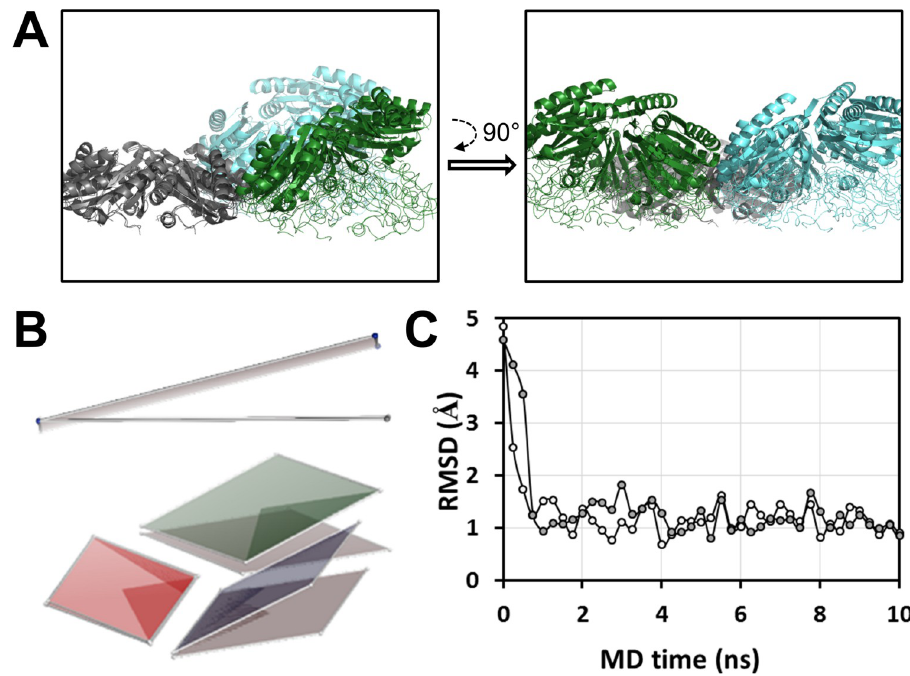
Fig 2. MD simulations on the PduA Sent tri-hexamer. A , Comparison of the average structure of a 20 ns MD simulation on PduA Sent (cartoon) with the situation at time 0, corresponding to the 3NGK crystal structure (thin traces). The two structures were superposed on backbone atoms of the most to the left hexamer (left view). An orthogonal view is shown in the right. B , The same comparison is illustrated by two means: On top, with planes that were elaborated from the coordinates of the center of mass (COM) of each hexamer. Grey spheres are from the starting structure, in blue for the MDs average structure. The view is approximately seen as in the left representation of panel A. Consequently, the traverse view of the plane in the crystal structure results in a flat trace. Bending during the MDs induces the trace to displace upwards or downwards. In the bottom representation, hexamers of the starting structure or MD average are represented by gray or colored planes, respectively. Each plane was prepared from the C α positions of Ala53 residues from the three monomers of each hexamer that contact other hexamers. C , Assembly evolution in the course of PduA Sent MD simulations. Plotted are the RMSD values calculated when the coordinates of backbone atoms from each snapshot structure (0,25ns steps) were compared to the MD average structure (empty circles for first MD, gray for the second run). All structures were superimposed prior to the